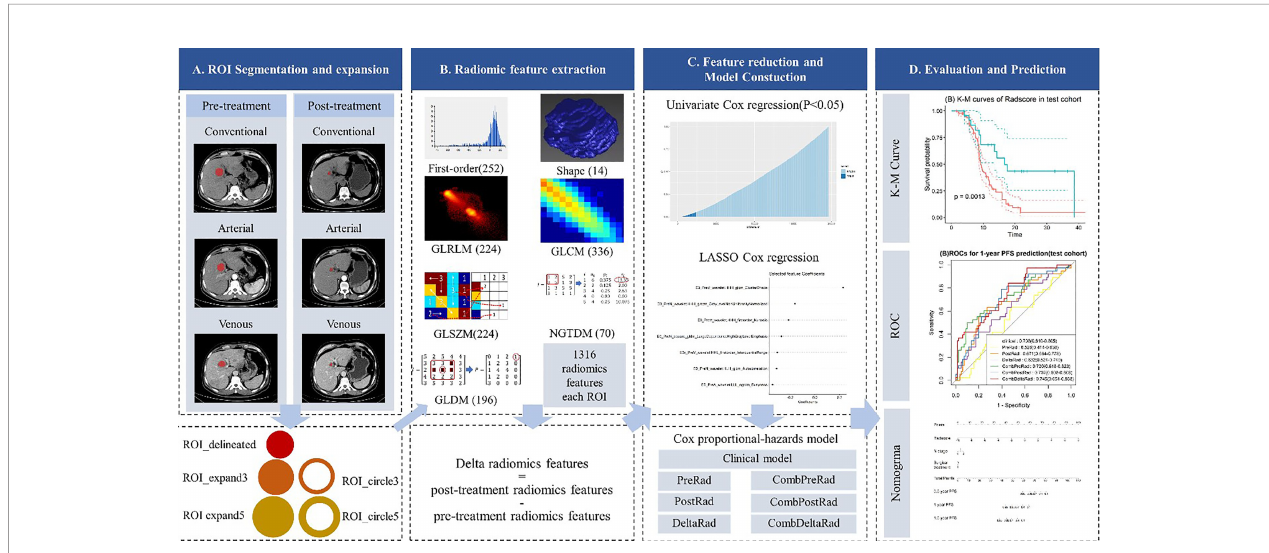
FIGURE 1 | Radiomics framework of predicting the PFS of patients with colorectal liver metastases undergo neoadjuvant chemotherapy. PFS, progress-free